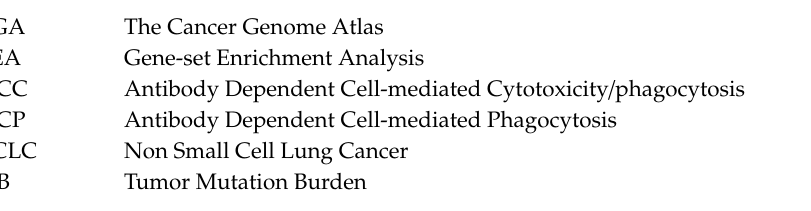
Figure S1: Diagram of the strategy to rank human cancer for their responsiveness to anti-CTLA-4 antibody treatment., Figure S2: Mutational burden varied across cancers from TCGA. Table S1: Patient information, related to Figure